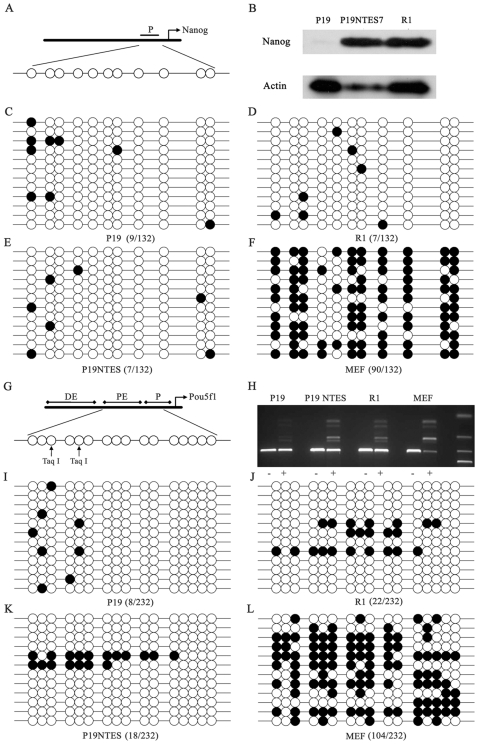
The expression analysis of Nanog, Pou5f1 and DNA methylation analysis of their specific promoter regions.In order to investigate the induction mechanisms of Nanog, bisulfite genomic sequencing was performed to analyze DNA methylation changes of its promoter region, which is the well-known regulatory element of Nanog, among P19, P19 NTES7 and R1, with Pou5f1 as control. (A) The CpG islands in the promoter region of Nanog are shown schematically. (B) The expression analysis of Nanog in P19, P19 NTES7, R1 and P19 NTES1 determined by western blot. From left to right, P19, P19 NTES7, R1 and P19 NTES1 are listed sequentially. (C), (D), (E), (F) The bisulfite genomic sequencing results of Nanog in P19, P19 NTES7, R1 and MEF are shown schematically. (G) The CpG islands in the promoter region of Pou5f1 are shown schematically; and the arrows show the recognition sites of Taq I. (H) The gel electrophoresis results of Pou5f1 digested by Taq I. (+): digested and (−): undigested. From left to right, P19, P19 NTES7, R1 and MEF are listed sequentially. The black circle represents the methylated CpG island; the white circle represents the unmethylated CpG island.